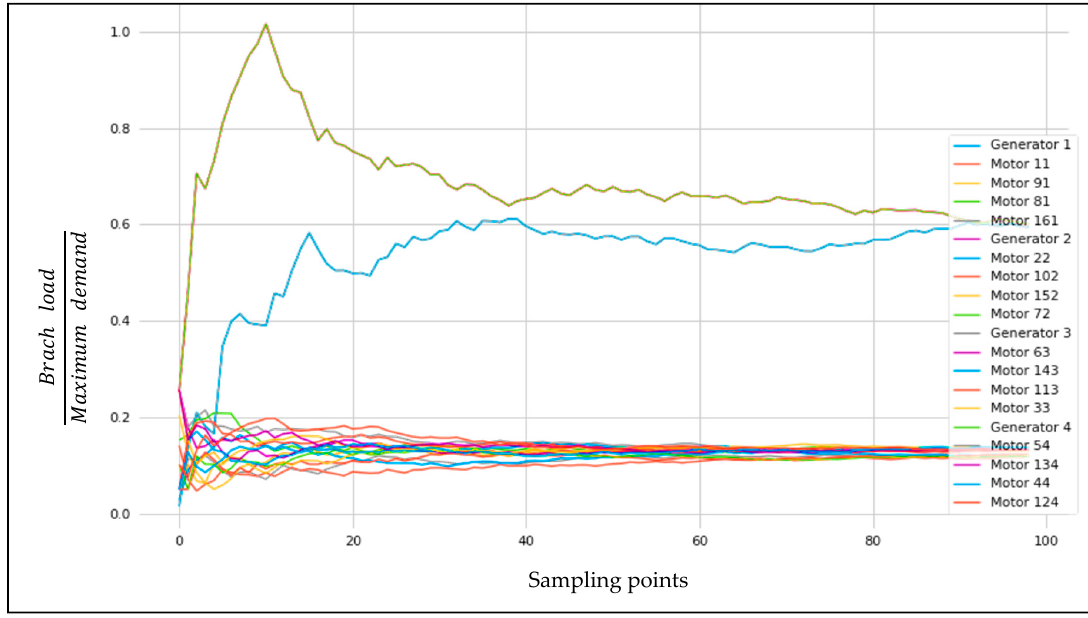
Figure 14. Latin hypercube RTO load average for NASA N3-X.